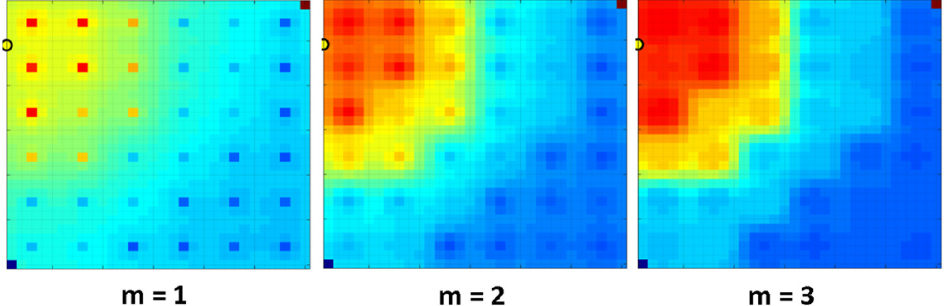
Table 1. Differential settlement metrics. Figure 2. Order of inverse distance weighted averaging: parameter ‘ m ’. Figure 2. Order of inverse distance weighted averaging: parameter ‘ m ’.